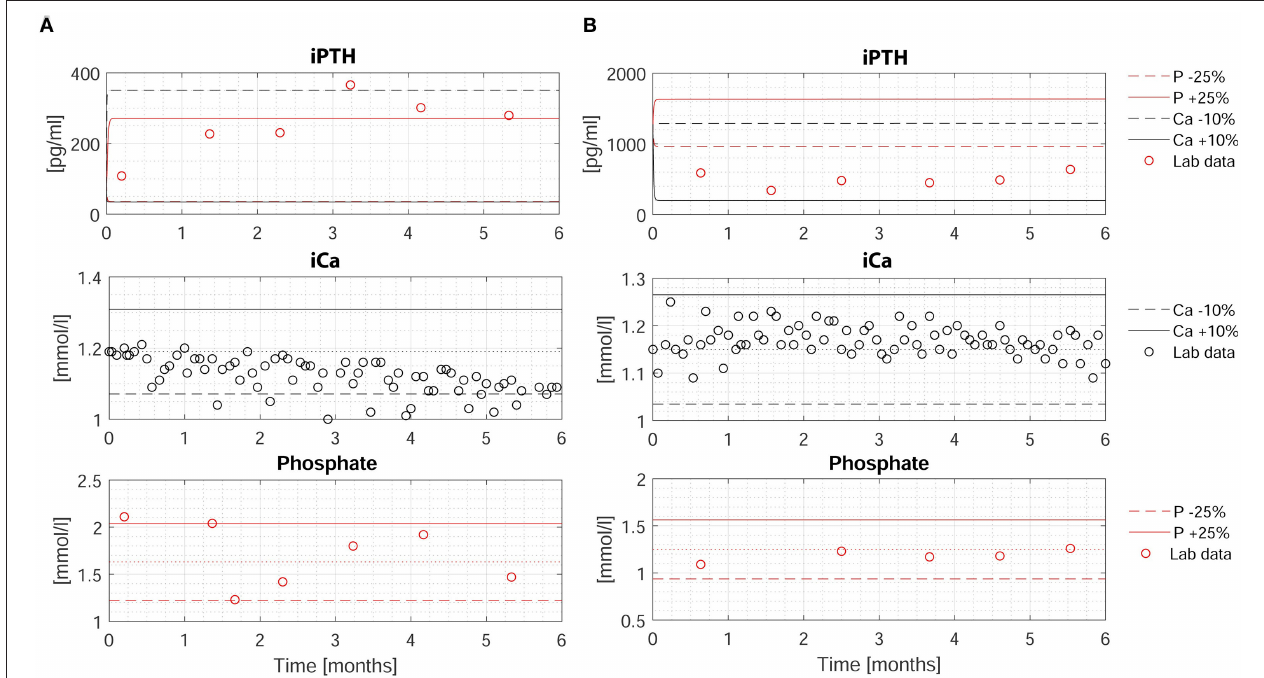
FIGURE 3 | Measured and predicted iPTH levels over 6-months period in two patients. (A,B) Upper: Measured (red circles) and predicted (dashed and solid lines) iPTH levels based on four different scenarios: (i) a decrease of phosphate by 25% (dashed red line); (ii) an increase of phosphate by 25% (solid red line); (iii) a decrease of iCa by 10% (dashed blue line); (iv) an increase of iCa by 10% (solid blue line). Middle: Measured iCa (black circles). The dotted line represents the baseline iCa concentration at the time of iCa mass balance assessment. The solid and dashed line represent + 10% and − 10% of the baseline value, respectively. Lower: Measured phosphate (red circles). The dotted line represents the baseline phosphate concentration at the time of iCa mass balance assessment. The solid and dashed line represent + 25% and − 25% of the baseline value, respectively. HD, hemodialysis; iCa, ionized calcium; iPTH, intact parathyroid hormone; P, phosphate.